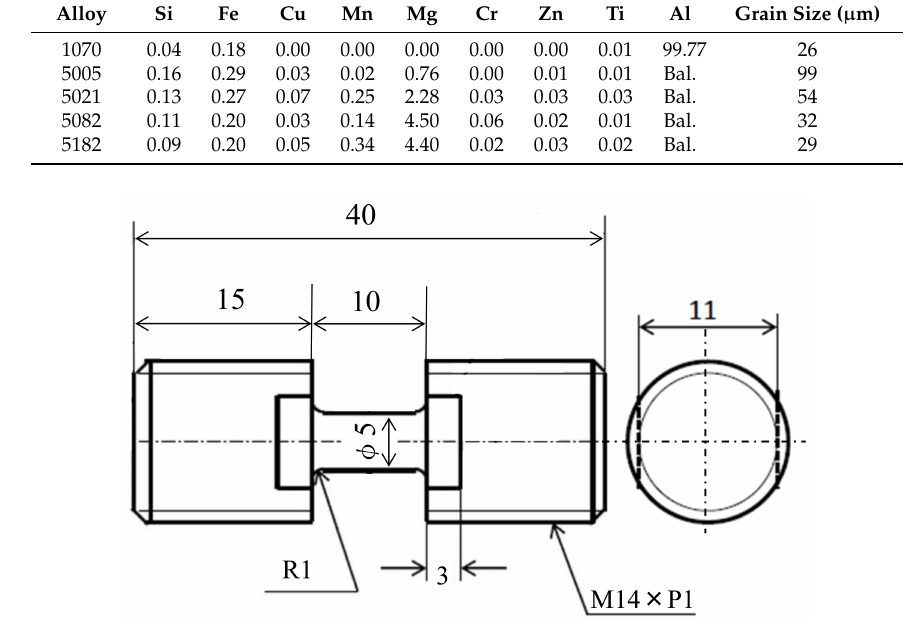
Figure 1. Specimen geometry